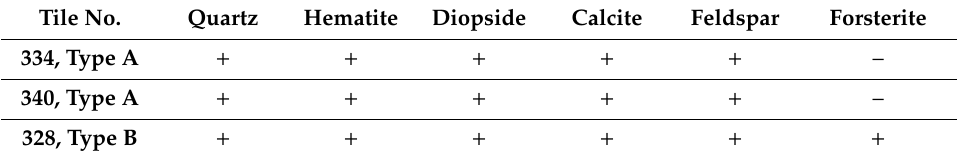
Table 1. Raman chemical analysis results, showing the presence of components of the clay bodies of Tiles 334, 340 (light brown clay, Type A), and 328 (red-brown clay, Type B), where “ + ” means “present” and “–” means absent. Tile No. Quartz Hematite Diopside Calcite Feldspar Forsterite 334, Type A + + + + + – 340, Type A